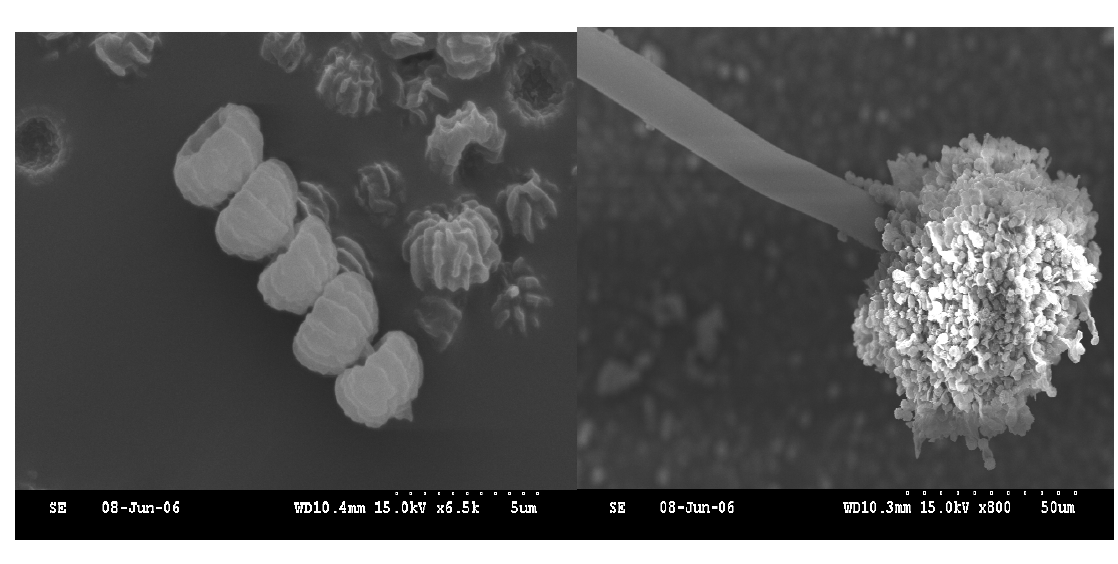
Figure 2. PCR amplification of β -tubulin gene. 1, DNA marker (100 bp); 2, PCR product of β -tubulin gene; 3, Water as